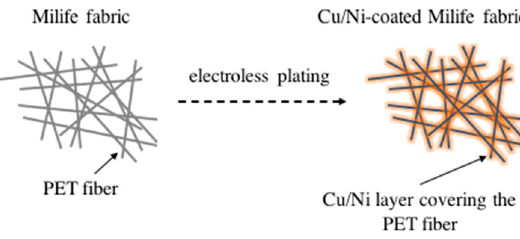
Figure 6. Structural change between the Milife fabric (N0) and the Cu/Ni-coated Milife fabric.